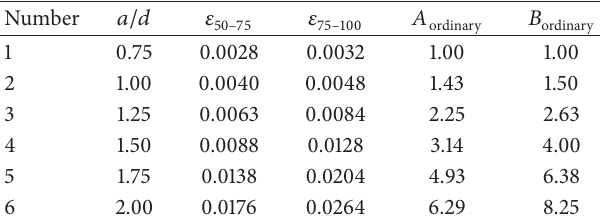
Figure 6: Comparison of average transverse strains of unstrength- ened RC struts for different applied load levels. Table 4: Average transverse strains of unstrengthened RC struts for different applied load levels.